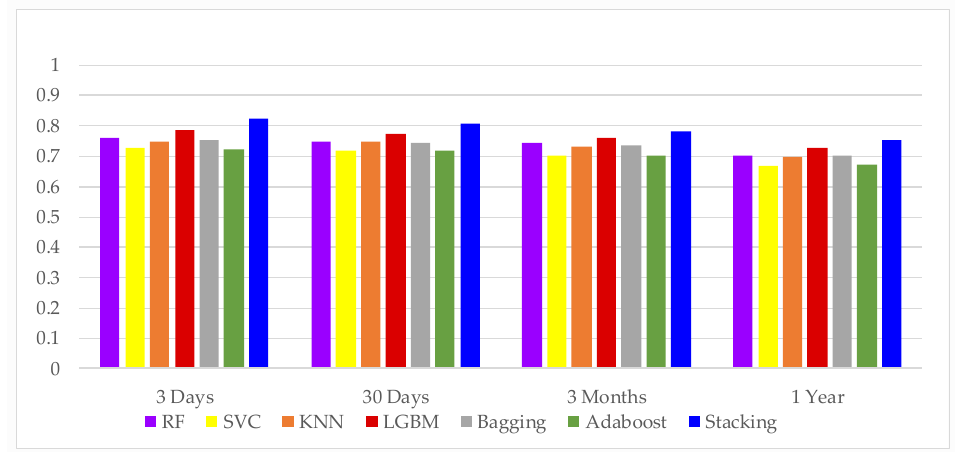
Figure 3. The AUROCs of different classifiers.